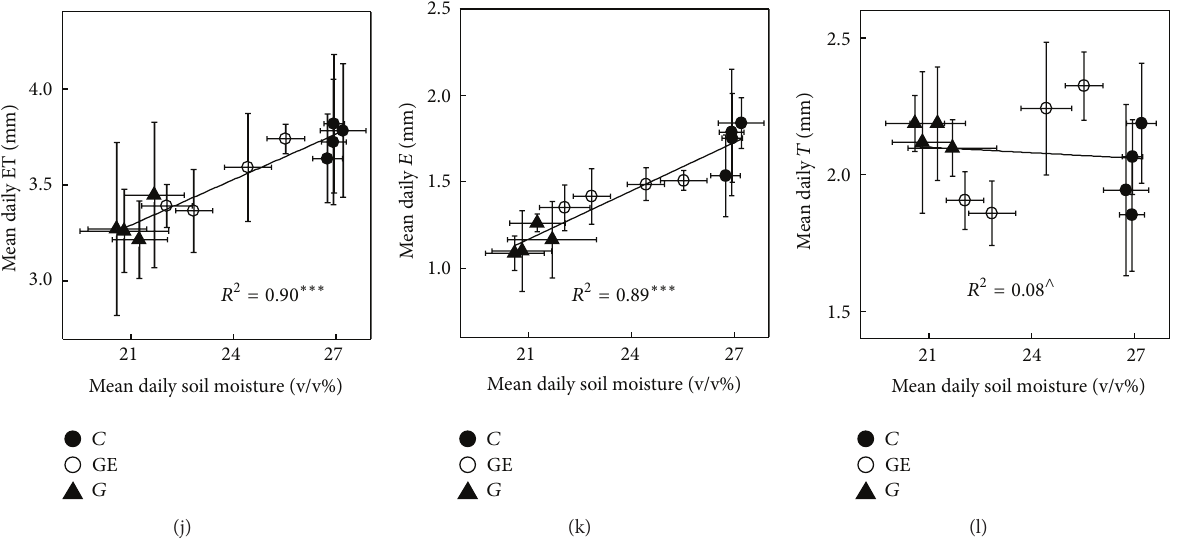
Figure 6: Relationships between mean daily water consumption components (E, T, and ET) on aboveground biomass, leaf area index (LAI), soil bulk density, and soil moisture across the three different steppe land uses. Error bar in WUE was 1SE. R 2 and probabilities of regressions are shown; ∧ 𝑃 > 0.05 ; ∗ 𝑃 < 0.05 ; ∗∗ 𝑃 < 0.01 ; ∗∗∗ 𝑃 < 0.001 . G, grazing; GE, grazing excluded; C, crop.